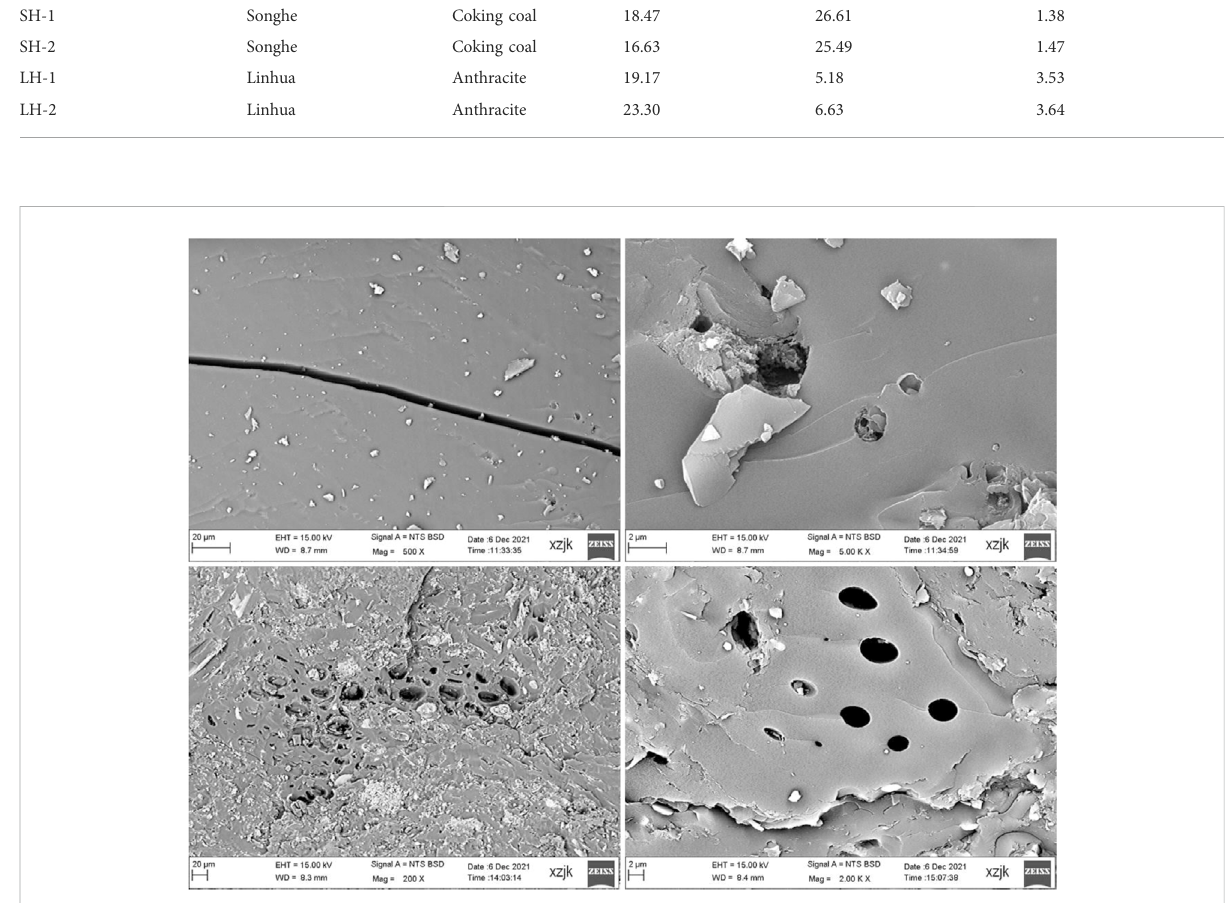
FIGURE 1 SEM images showing pore characteristics in coal